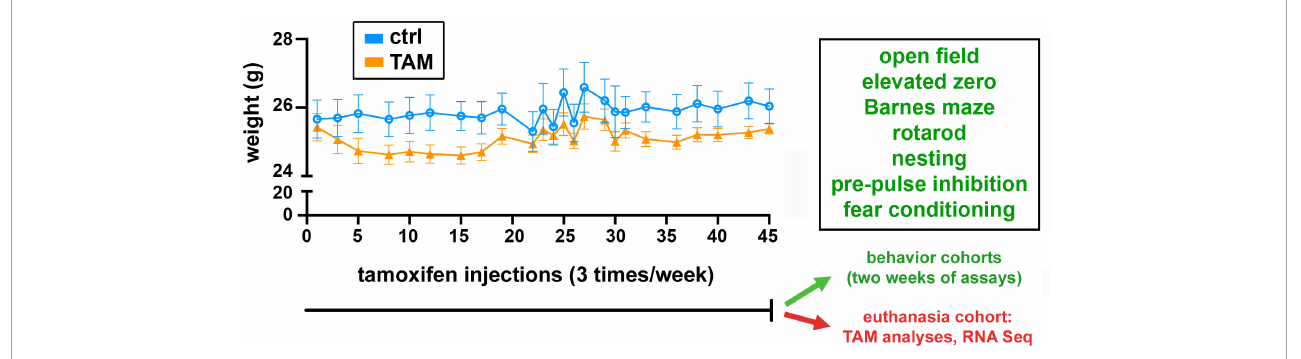
FIGURE1 Timeline of tamoxifen or vehicle exposure and associated weight changes, behavioral assessments, and euthanasia. All cohorts of wild-type mice were treated with tamoxifen (TAM) or vehicle control (CTRL) for 45 days. Mice were injected three times per week, and weighed each time. One cohort of 15 mice was then euthanized for tamoxifen metabolite and RNA sequencing analyses. Two other cohorts of 16 mice each were used in the series of indicated behavioral tests over 2